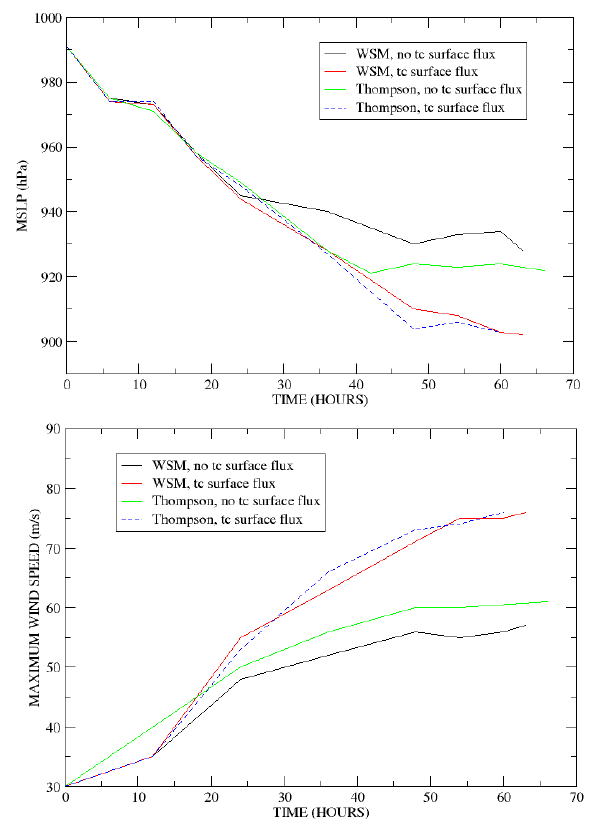
Figure 8. WRF simulations MSLP (upper) and maximum surface winds (lower) versus